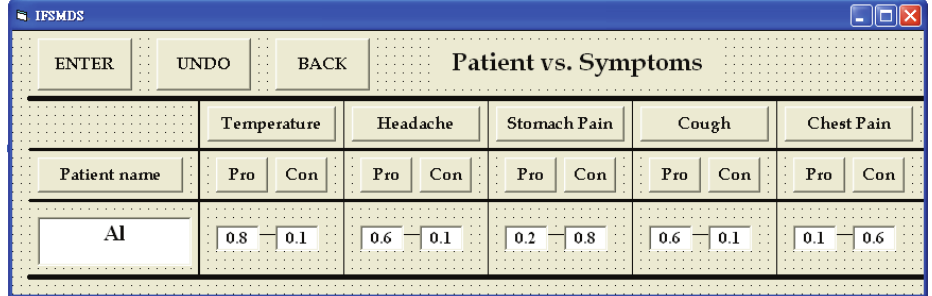
Fig. 6. Input intuitionistic diagnosed value on each symptom for patient.